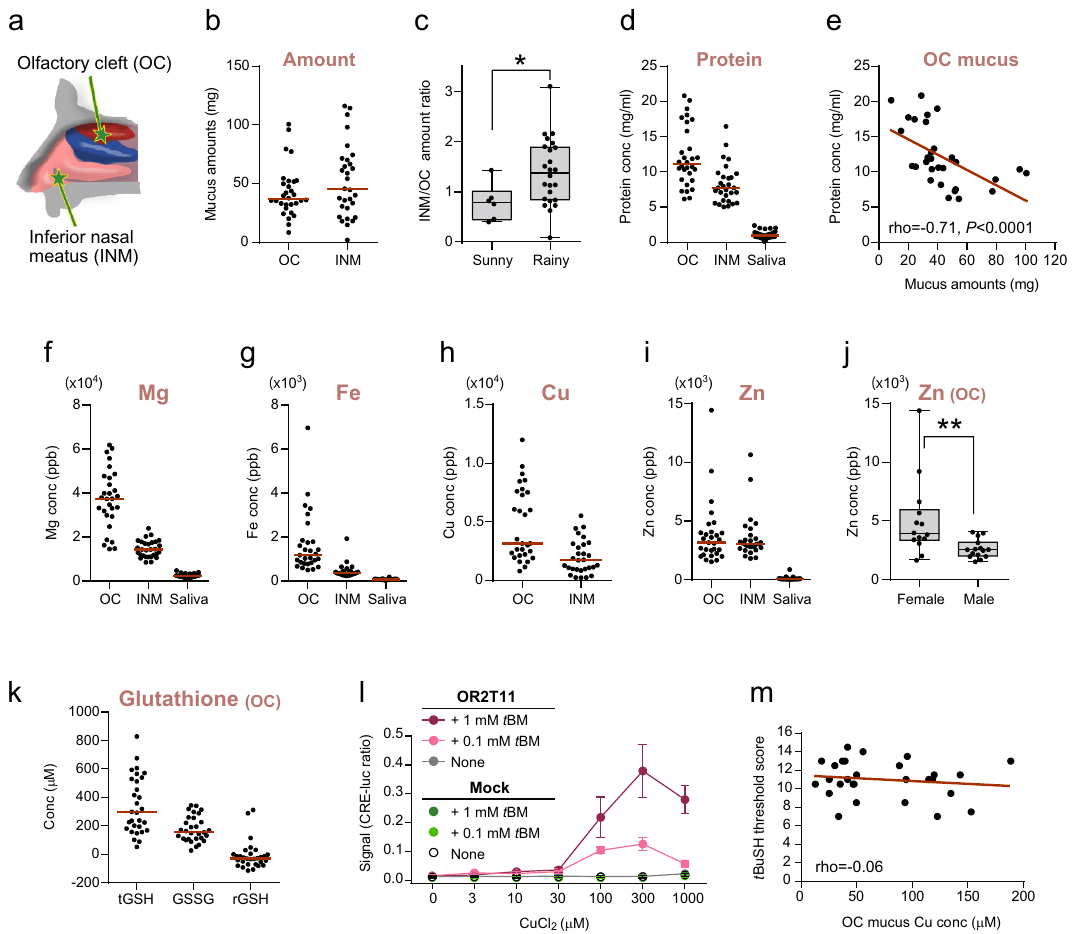
Figure 1. Basic properties and individual variability of olfactory mucus. ( a ) Schematic drawing of the human nasal cavity showing the location of mucus sampled in this study. Mucus samples were collected from the olfactory cleft (OC) and inferior nasal meatus (INM). ( b ) Distribution and median value (red horizonal line) of nasal mucus amount collected from 30 participants. Each dot represents the average amount of mucus from the left and right nostrils of a subject. ( c ) Weather dependency of the amount of INM mucus collected. The amount of INM mucus was normalized to the amount of OC mucus. The whisker plots show the median, first and third quartiles, and upper and lower limits in the rainy weather (n = 6) and sunny weather (n = 24) groups. ( d ) Distribution of total protein concentration in the OC mucus (n = 30), INM mucus (n = 29), and saliva (n = 30). ( e ) Correlation between the amount and protein concentration in the OC mucus (n = 30). ( f–i ) Distribution of Mg, Fe, Cu, and Zn concentrations in the OC mucus (n = 29), INM mucus (n = 29), and saliva (n = 30). Cu ion was not detected in the saliva. ( j ) Female-specific enrichment of Zn in the OC mucus. Zn concentration in the mucus of 14 female and 15 male participants are plotted. ( k ) Concentration of total glutathione (tGSH), oxidized glutathione (GSSG), and reduced glutathione (rGSH) in the OC mucus (n = 30). ( l ) Dose–response analysis of the activation of OR2T11-expressing HEK293T cells against 0.1 mM or 1 mM of tert -butyl mercaptan ( t BM) with increasing concentrations of CuCl 2 supplemented in the cell culture medium. Data are shown as the mean ± SE from three independent experiments. Cells transfected without OR2T11 were also assayed (mock). ( m ) No significant association between Cu concentration in the OC mucus and olfactory threshold score was found (n = 28 participants). Spearman’s correlation was also not statistically significant ( P > 0.05). Significance was assessed with a Mann–Whitney U-test. *, P = 0.0255; **, P =